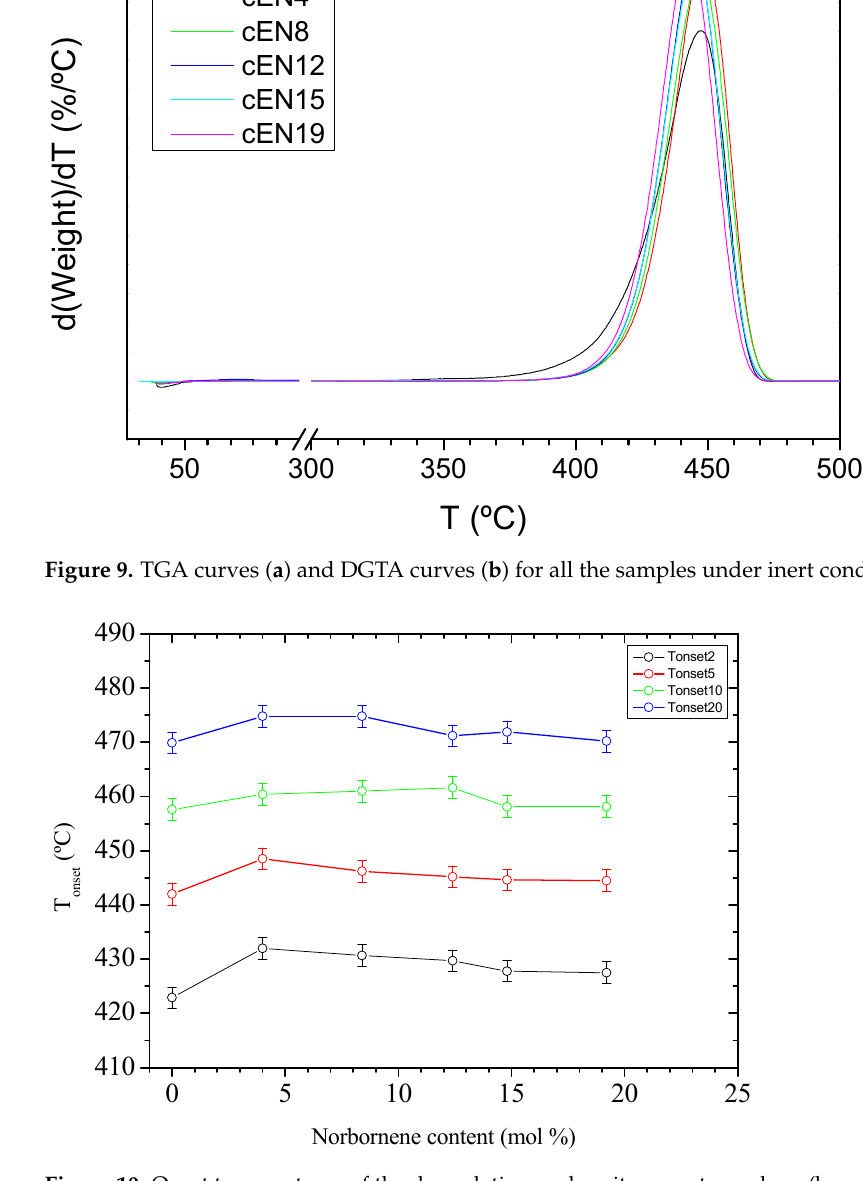
Figure 11. Activation energies associated with the weight loss under inert conditions (bars corre- spond to a relative error of 5%). The behavior of EN copolymers, showing higher onset temperatures for the weight loss oxidation process than PE, but lower Ea for pyrolysis, has important consequences for both the applicability and sustainability of these materials. They are thus expected, on one hand, to exhibit higher performance against oxidation, while on the other hand, be converted into other chemicals at the end of their service life by using less energy-de- manding processes, due to their lower Ea of pyrolysis. 4. Conclusions A family of random COC copolymers based on ethylene and norbornene were syn- thesized in a broad range of compositions (up to 19 mol % in norbornene) through metal- locene catalysis. A negative comonomer effect was observed over the catalytic activity in the kinetic analysis. Furthermore, the microstructure in composition shows a clear rela- tionship with the comonomer ratio in the feeding, which can be described by a second- 0